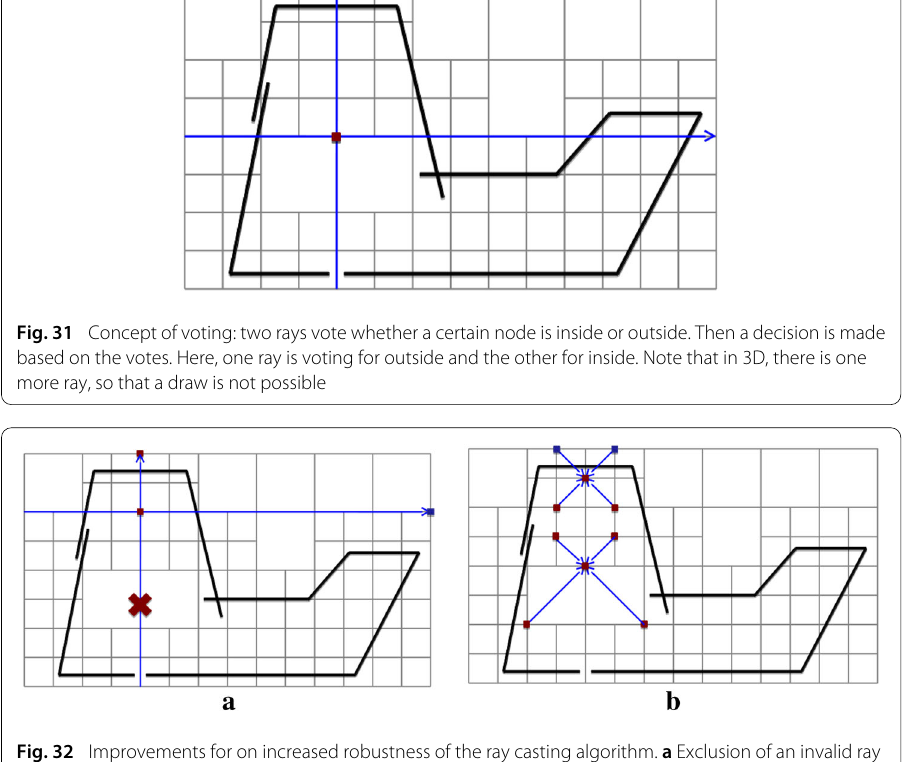
Fig. 32 Improvements for on increased robustness of the ray casting algorithm. a Exclusion of an invalid ray from voting. b Local ray casting exclusion of an invalid ray prevents false conclusions with respect to a node position is given in Fig.